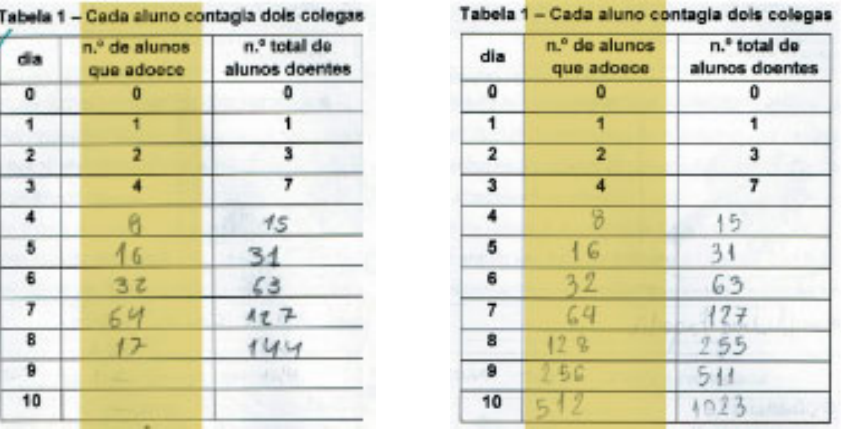
Figure 2. Each student infects two colleagues.